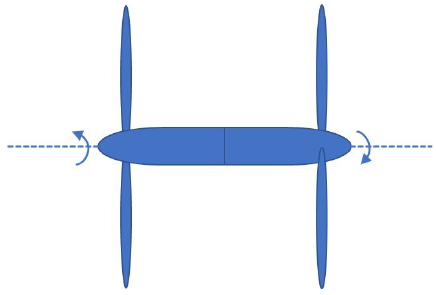
Figure 11. Twin rotor secondary-rotor